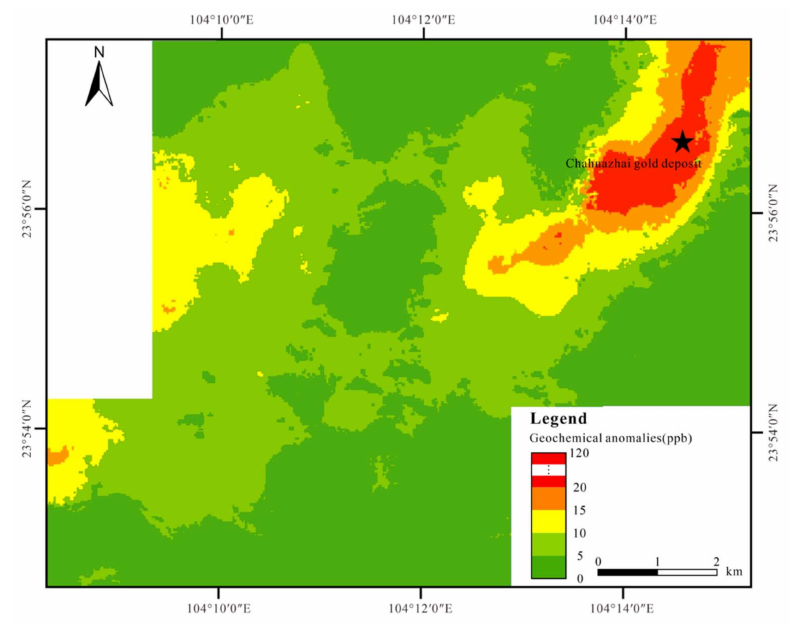
Figure 14. GWR prediction results of geochemical anomalies. According to the field work results, the geochemical anomaly values of the field soil samples at No. 1, 2, 3 are 368 ppb, 308 ppb, and 24 ppb, respectively. The trend of the field data is generally consistent with the trend of the prediction results (Figure 15).